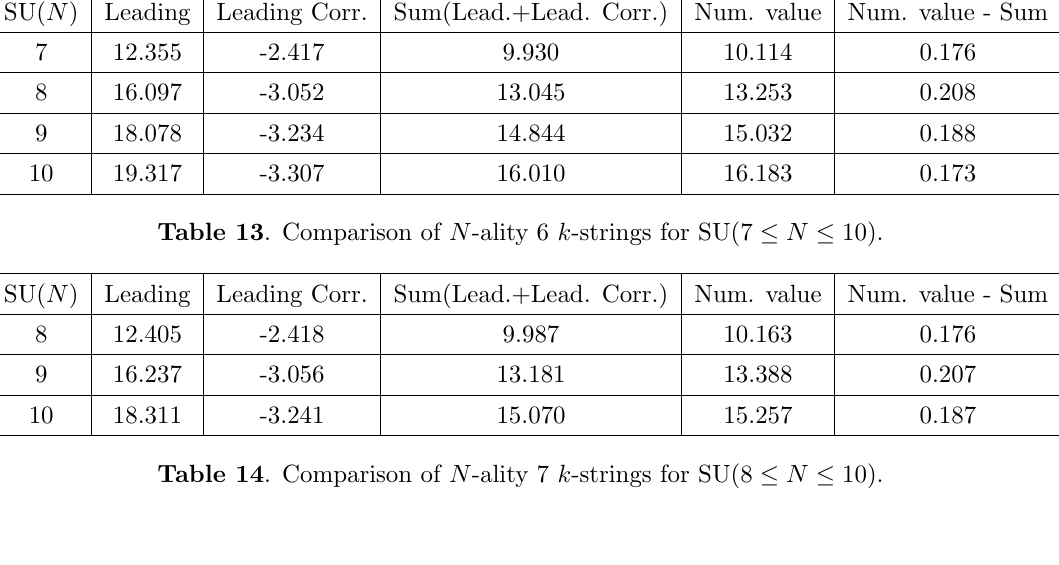
N 10). (cid:20) (cid:20)